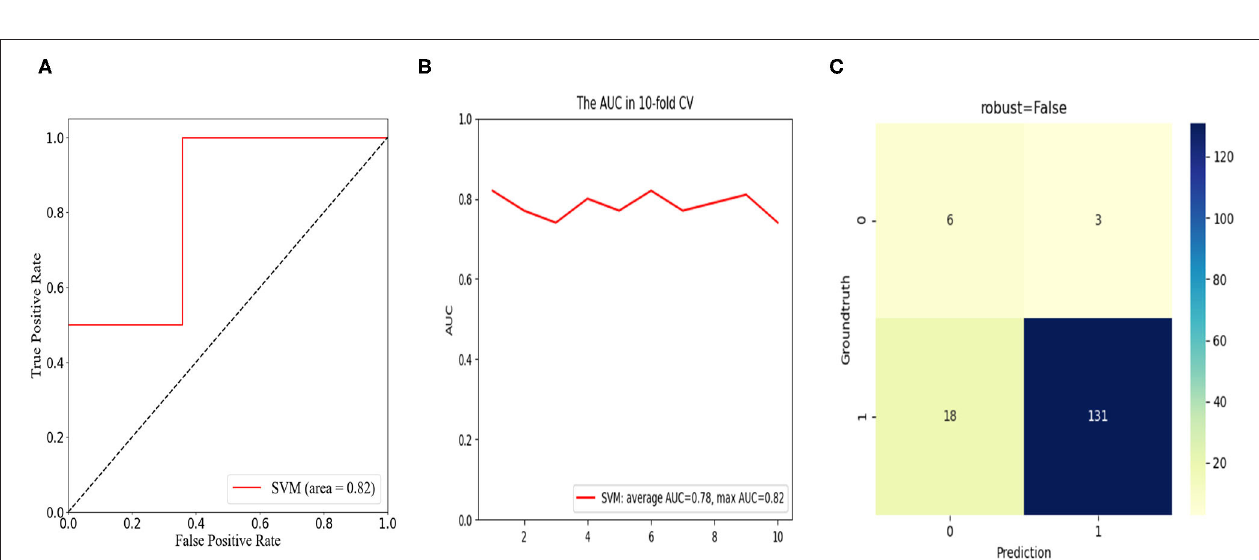
FIGURE 6 | In the long-term cohort, receiver operation characteristic (ROC) curve analysis of the SVM model with the maximum value of 0.82 (A) ; ROC curve analysis of 10-fold cross validation of the SVM model for predicting the risk of unfavorable clinical outcomes, following LIF with average AUC of 0.78 and max AUC of 0.82 (B) ; confusion matrix of the SVM model (C)